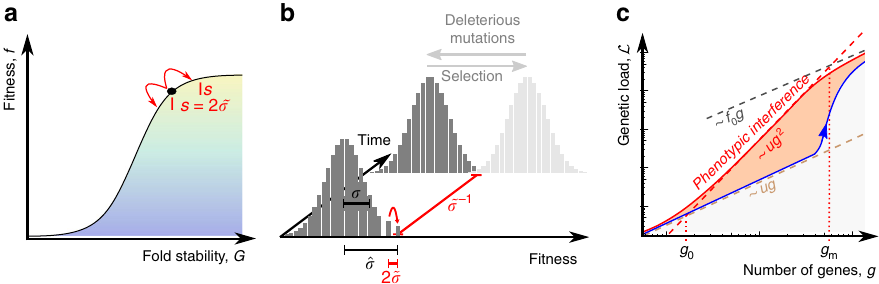
Fig. 1 Phenotypic interference. Phenotypic interference is an evolutionary mode of multiple quantitative traits under genetic linkage with the following features: a Local evolution. Individual traits G change by mutations (red arrows) with mean square selection coef fi cient s 2 set by the slope of the fi tness landscape f ( G ). In housekeeping equilibrium, the traits have detailed balance between bene fi cial and deleterious substitutions 30 . b Global evolution proceeds in a fi tness wave, i.e., multiple genetic and phenotypic variants co-exist in a population 5,7 – 9,11 – 13 . The wave is fueled by new bene fi cial mutation at ffiffi p σ with a factor c depending weakly on the population size (see Methods its tip (red arrows). It has fi tness variance σ 2 and a total fi tness span ^ σ ¼ c ffiffi p section). By Fisher ’ s theorem, these quantities determine the coalescence rate ~ σ ¼ σ 2 = ^ σ ¼ σ = c (see Methods section). Its inverse is the coalescence time (i.e., the average time to the most recent common ancestor of two individuals), which is proportional to the effective population size, ~ σ (cid:2) 1 ¼ 2 N e (red bar) 13,14 . In housekeeping equilibrium, the selective advance (light gray) is offset by deleterious mutations, i.e., there is no net (local or global) change in fi tness 12,77 (dark gray). Feedback between global and local evolution: the global coalescence rate sets selection on individual traits, s 2 ¼ 4 ~ σ 2 (Eq. 3). The wave complexity, measured by the number of simultaneously segregating bene fi cial trait mutations destined for fi xation, is of order 2 ^ σ = s ¼ c (Eq. 21). (red line, see text). This load is c Superlinear load. The genetic load L depends quadratically on the number of genes, g , over a broad range g 0 ≲ g ≲ g m substantially higher than the load under asexual evolution with discrete gene fi tness effects (blue) and under of recombination